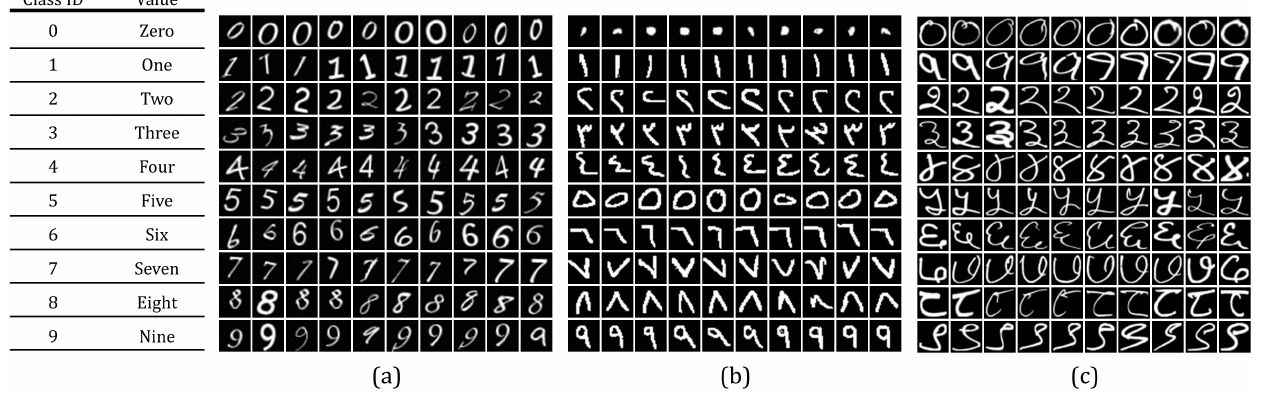
Figure 4. Samples from dataset images ( a ) Roman, ( b ) Arabic, and ( c ) Devanagari.